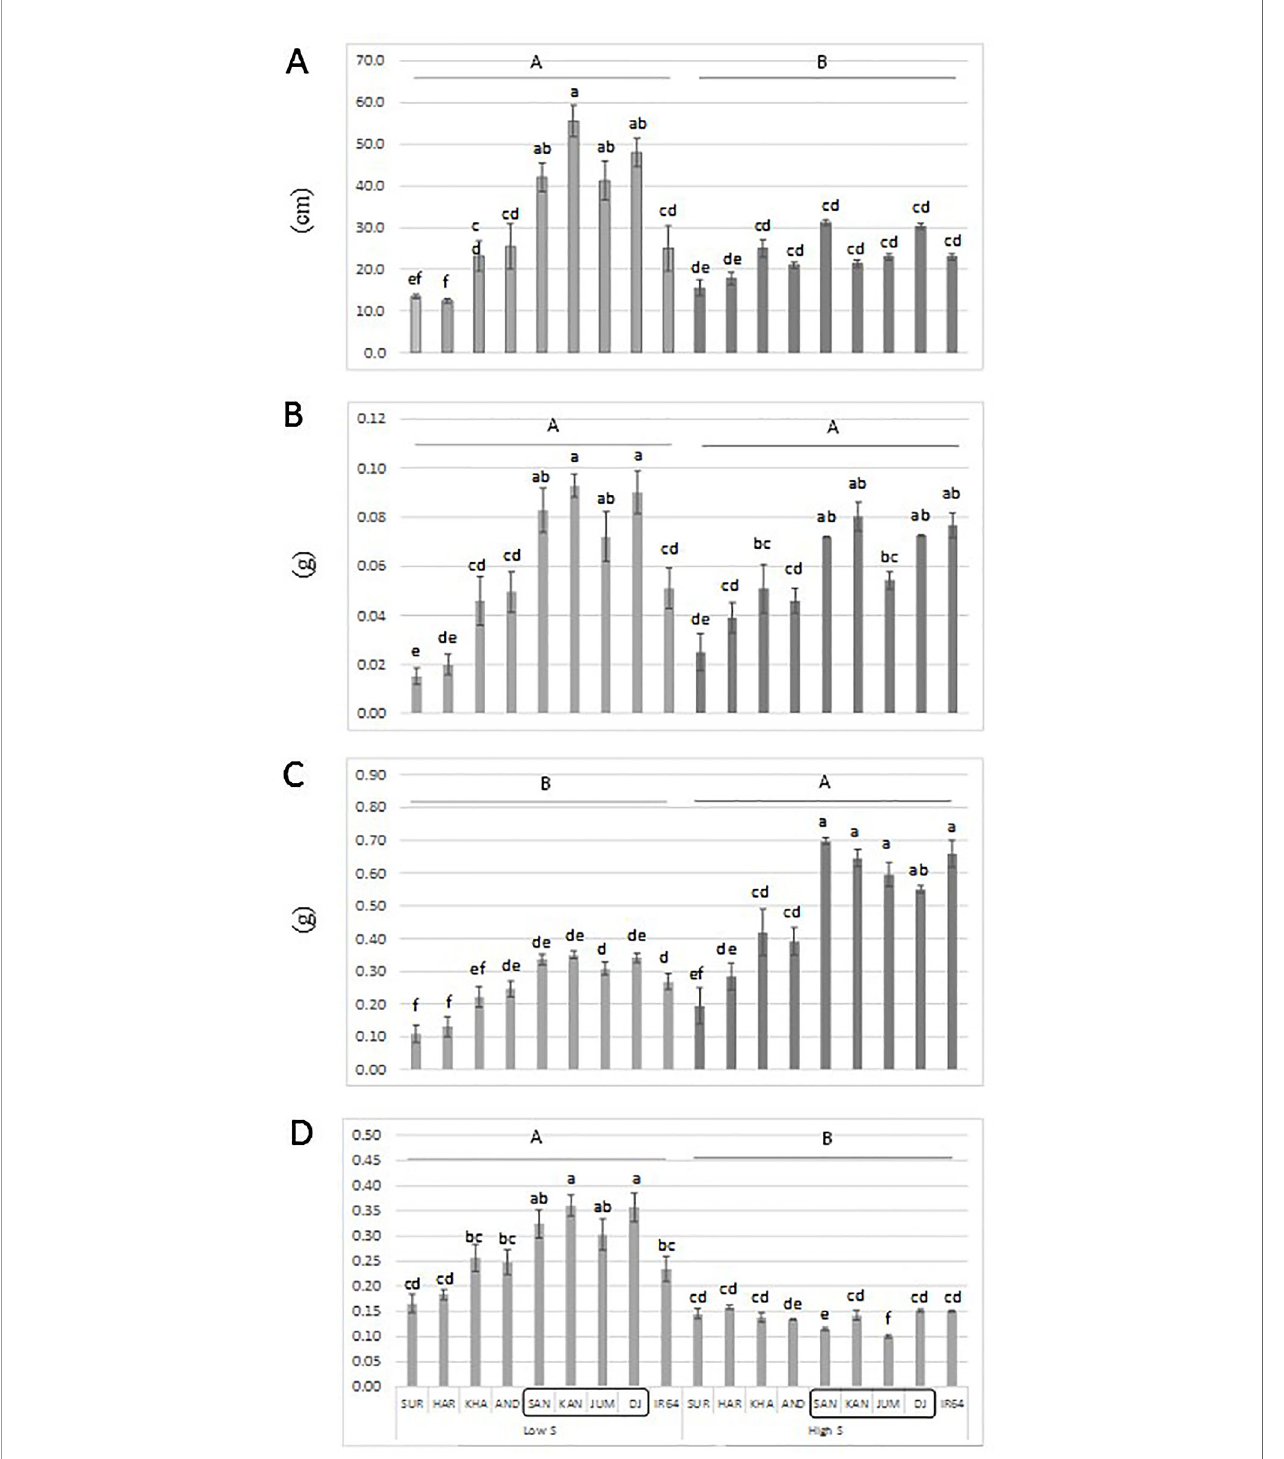
FIGURE 4 | Root length (A) , root dry matter (B) , total dry matter (C) and root:shoot ratio (D) of a set of aus genotypes grown under low-S or high-S condition. Genotypes included in the box harbor the favorable haplotype for total dry matter. Data represent the mean (± standard error, SE) of three independent replications (n = 3) and analyzed by two-way ANOVA. Different letters indicate signi fi cant difference within either factor: S treatment (capital letter) or genotype (small letter) according to Tukey's Honest Signi fi cant Difference test ( P < 0.05). ANOVA results are provided in Supplementary Table S4-2 in Data Sheet 1 . SUR, Surja Mukhi; HAR, Harbhoondi; KHA, Khadasiya3; CHU, Chungur Bali; AND, Andikulan; NP, NP 125; SAN, Santhi Sufaid207; KAN, Kangro; JUM, Juma; NCS, NCS 160; DJ,